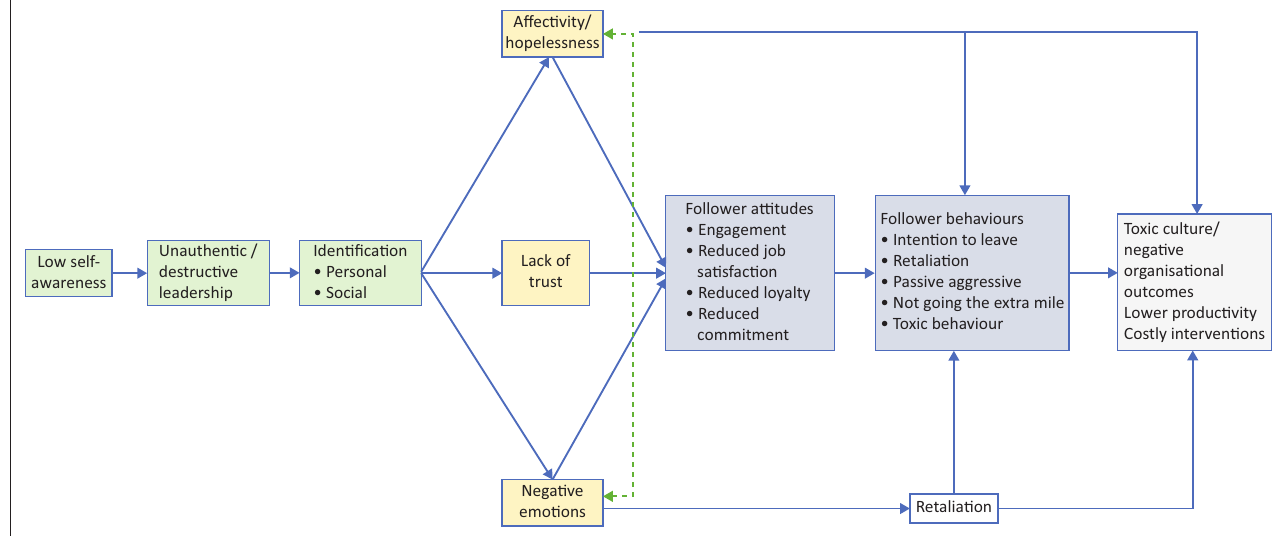
FIGURE 4: Proposed framework linking destructive leadership to followers’ attitudes and